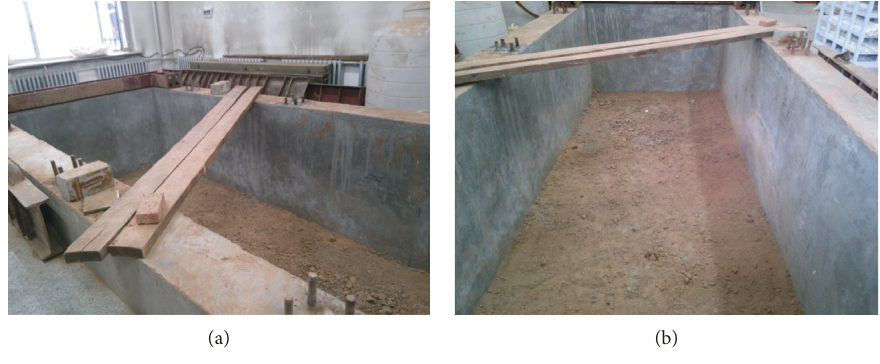
Figure 1: The concrete test box.